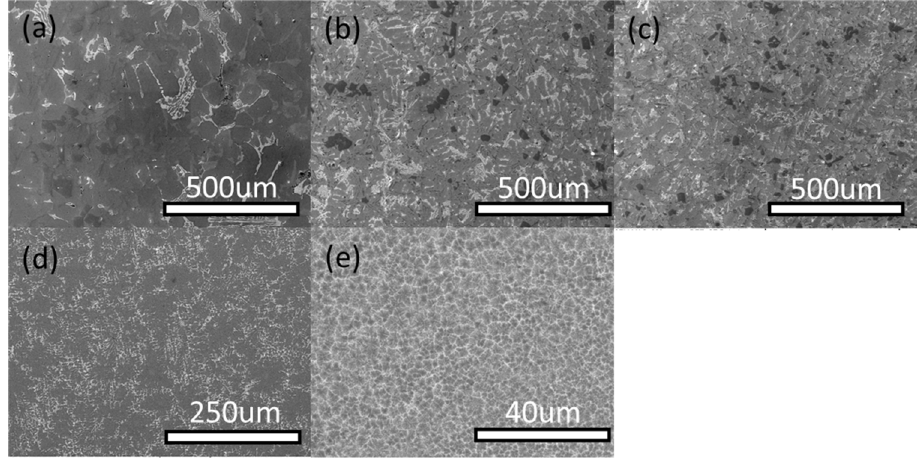
Figure 2. SEM analysis in the Al-13Si-4Cu-1Mg-2Ni alloy solidified with different cooling rates: ( a ) 0.15 °C/s; ( b ) 1.5 °C/s; ( c ) 15 °C/s; ( d ) 150 °C/s; ( e ) 1.5 × 10 5 °C/s.